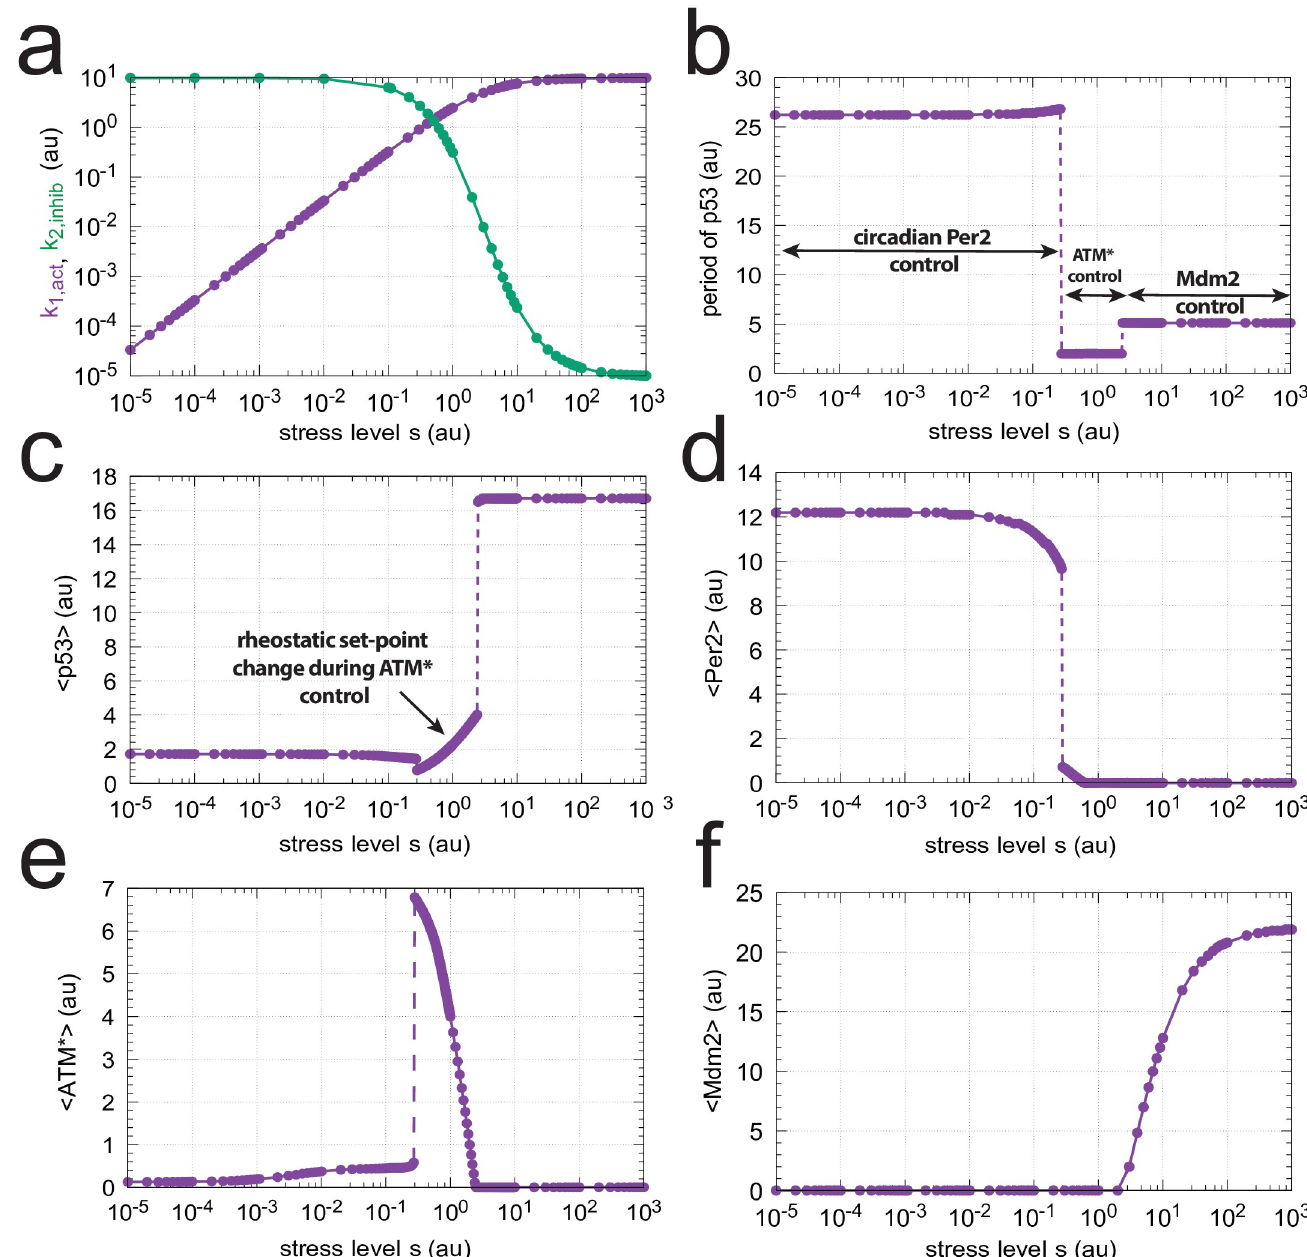
Fig 9. Change of steady state levels in the model (Fig 8) as a function of stress level s . (a) Change of k 1, act (Eq 28) and k 2, inhib (Eq 29), (b) p53 period length, (c) average p53 concentration < p53 > ; inset: same figure, but abscissa ( s ) is linear. (d) average Per2 concentration < Per2 > , (e) average ATM � concentration < ATM � > , and (f) average Mdm2 concentration < Mdm2 > . Parameter values: k 1 = k 2 = 10.0, k 3 = 3.0, k 4 = 50.0, k 5 = 1 × 10 − 6 , k 6 = 0.7, k 7 = 0.5, k 8 = 1.2, k 9 = 1.0, k 10 = 1 × 10 − 6 , k 11 = 0.85, k 12 = 0.7, k 13 = 1 × 10 − 6 , k 14 = 1.0, k 15 = 0.7, k 16 = 1 × 10 − 6 , k 17 = k 18 = 1 × 10 3 , k 19 = 0.0, k 20 = 10.0, k 21 = 0.5, k 22 = 0.0, k 23 = 1 × 10 6 , k 24 = 1 × 10 3 , k 25 = 0.0, k 26 = 90.0, k 27 = 10.0, k 28 = 1 × 10 − 6 , k 29 = 1.0, k 31 = 1.0, K Initial concentrations: p53 0 = 1.49, Mdm2 0 = 9.84 × 10 − 8 , Per2 0 = 3.82 × 10 − 2 , Bmal/Clk 0 = 1.00, Per1 0 = 1.48 × 10 − 1 , Per1 ��� Per2 0 = 5.66 × 10 − 3 , (Per1 2 ) 0 = 1.82 × 10 − 1 , (Per2 2 ) 0 = 1.46 × 10 − 6 , ATM �